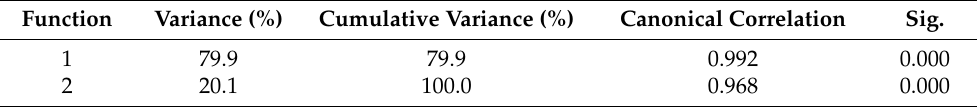
Table 8. Characteristics of typical discriminant function of stepwise DFA of source group